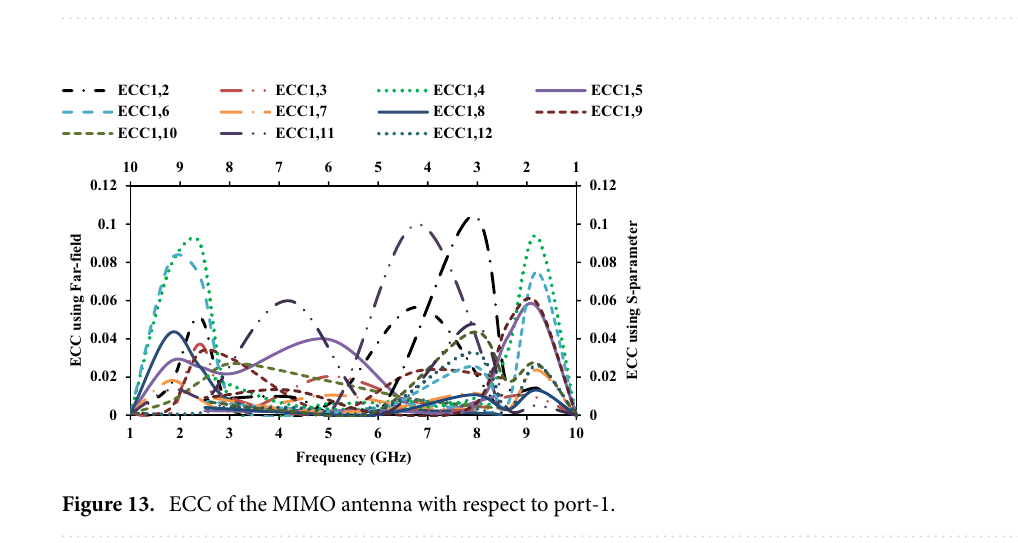
Figure 12. Gain and efficiency of the proposed antenna.